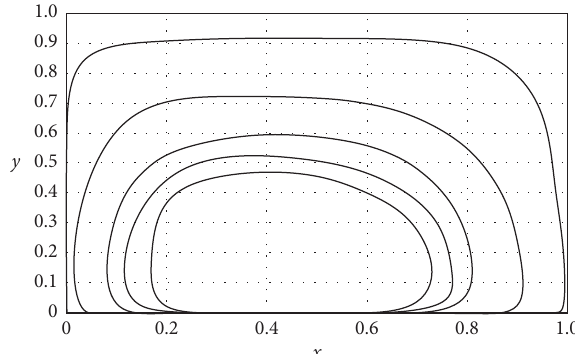
Figure 4: Dynamic evolution of government and enterprise strategy ( d ).